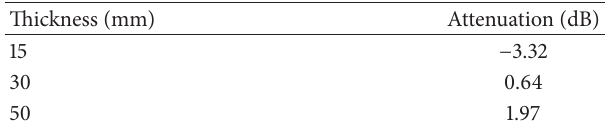
Table 2: Values of attenuation at different material